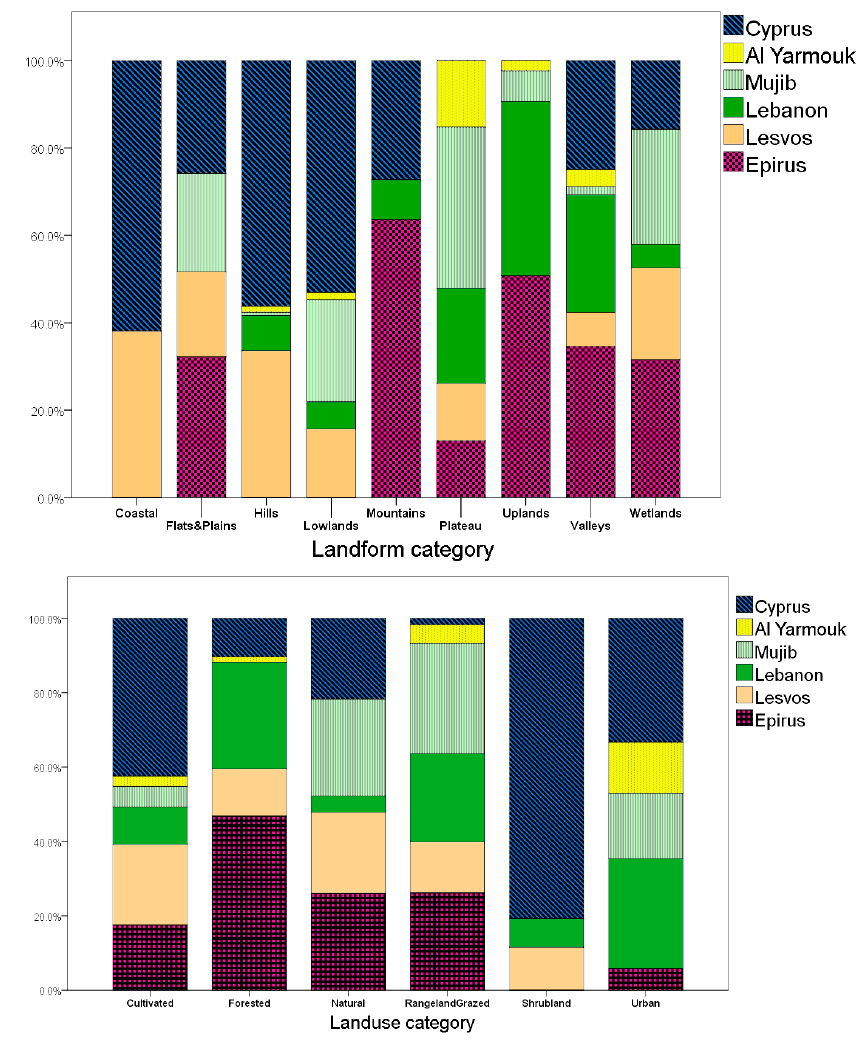
Figure 3. Landscape Profile of the study areas in terms of landuse and landform. Table 3. Summary of the Eastern Mediterranean